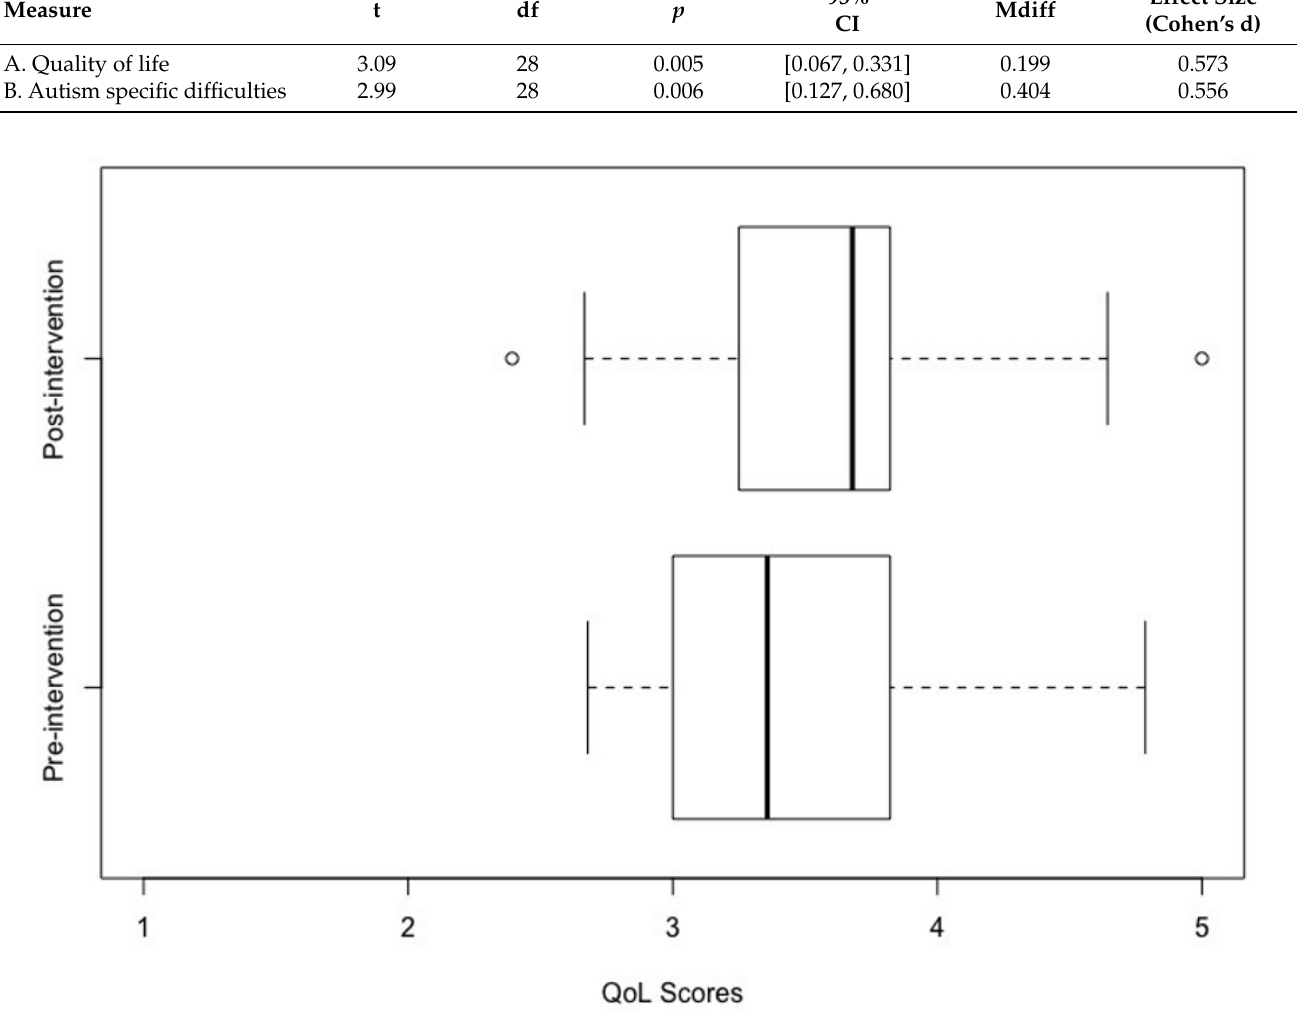
Figure 1. Effect of intervention on perceived quality of life scores. Intervention (binary variable i.e., pre- and post-intervention) is plotted on the y-axis, while QoLA-A scores (range: 1 to 5) are plotted on the x-axis. Note: Higher scores on the x-axis reflect better perceived quality of life.